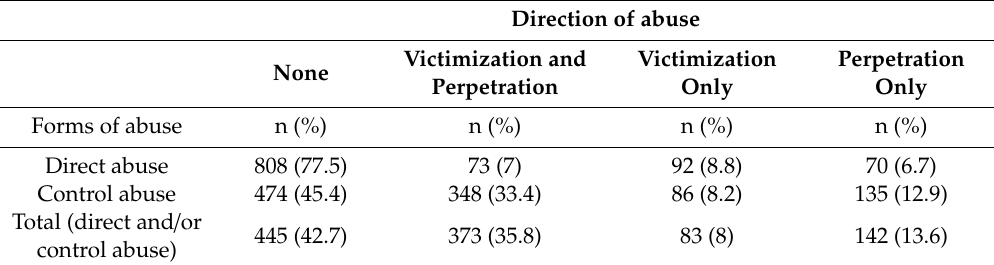
Table 2. Prevalence rates of cyber dating